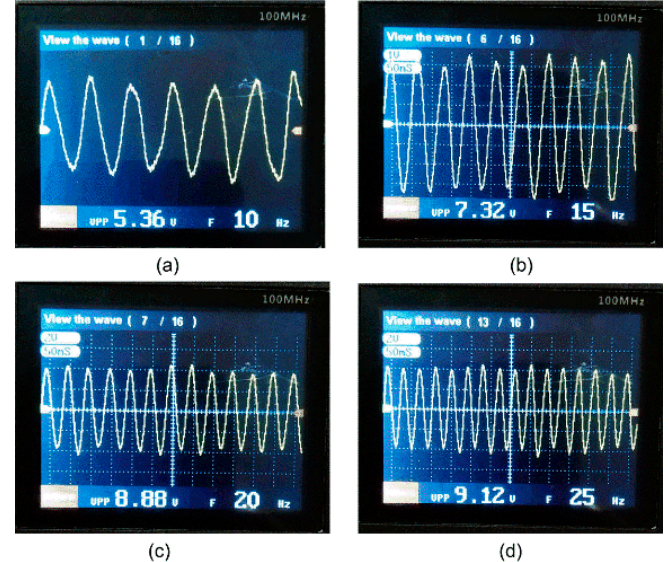
Figure 5. Instantaneous snapshots of four sinusoidal waveforms ( a ) 10 Hz; ( b ) 15 Hz; ( c ) 20 Hz; ( d ) 25 Hz taken by a portable oscilloscope, without noise.